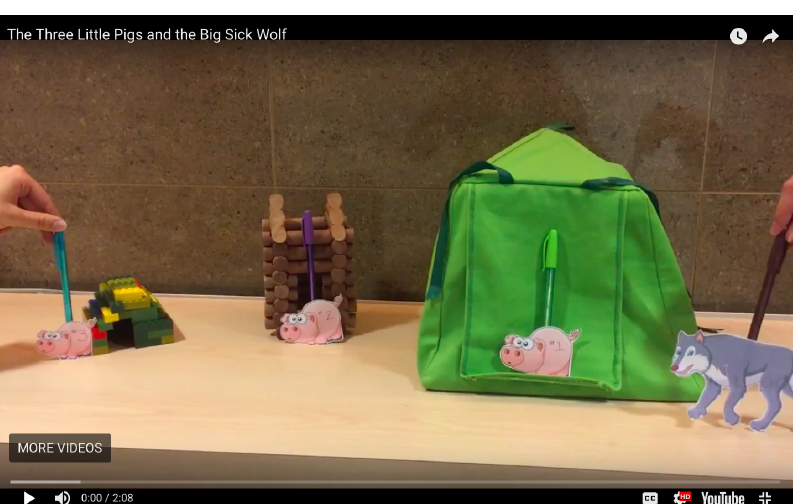
Figure 2. Screenshot of student mentor video: The dramatization of Three Little Pigs from the wolf’s perspective, using stick puppets.